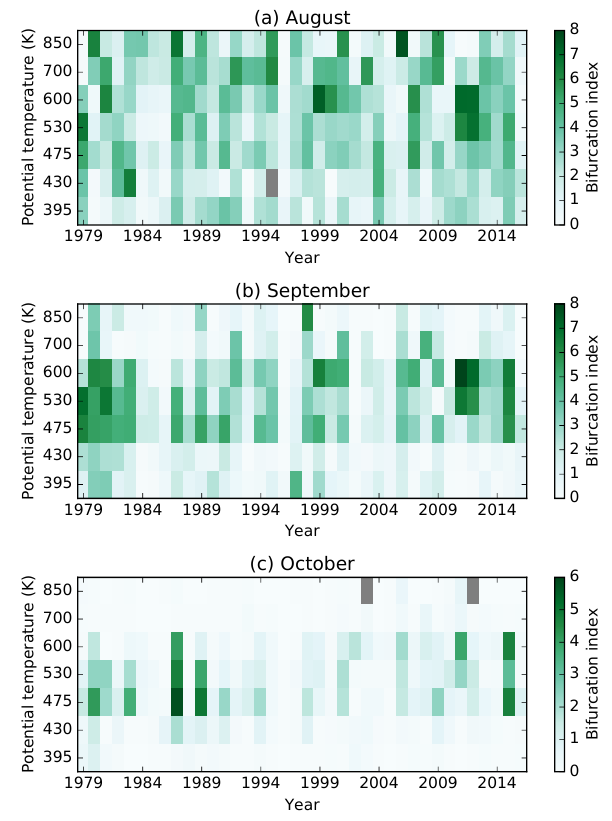
Figure 6. Time series of monthly average BI at ERA-Interim levels between 395 and 850K, 1979–2016. Grey colours indicate months with greater than 50% of profiles that do not meet the minimum wind speed and PV gradient